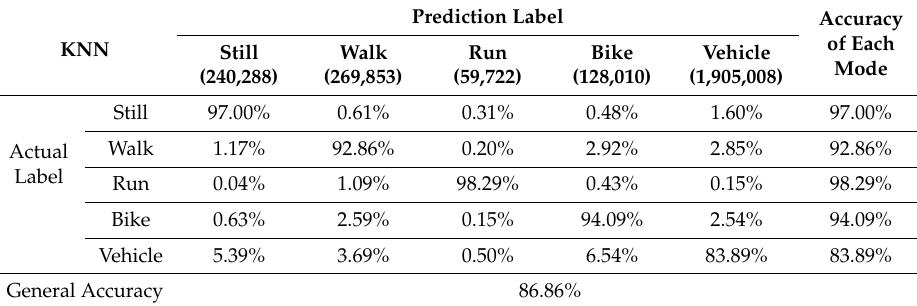
Table 6. Confusion matrix support vector machine with the proposed 14 features.